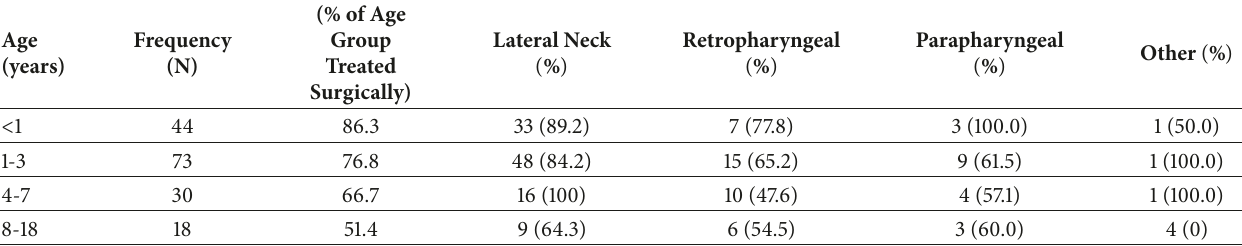
Table 2: Percentage of children in each age group who underwent operative intervention for neck abscess with location of abscess (% represents % for each